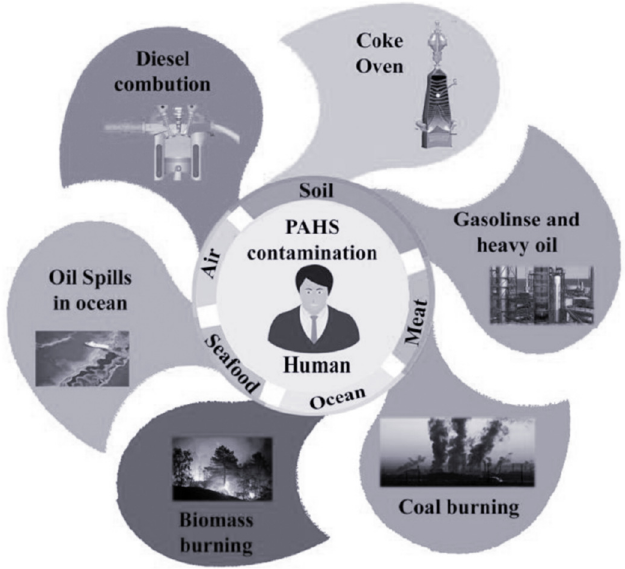
Figure 2. PAH contamination in a diverse environment (License Number: 5411951000689)